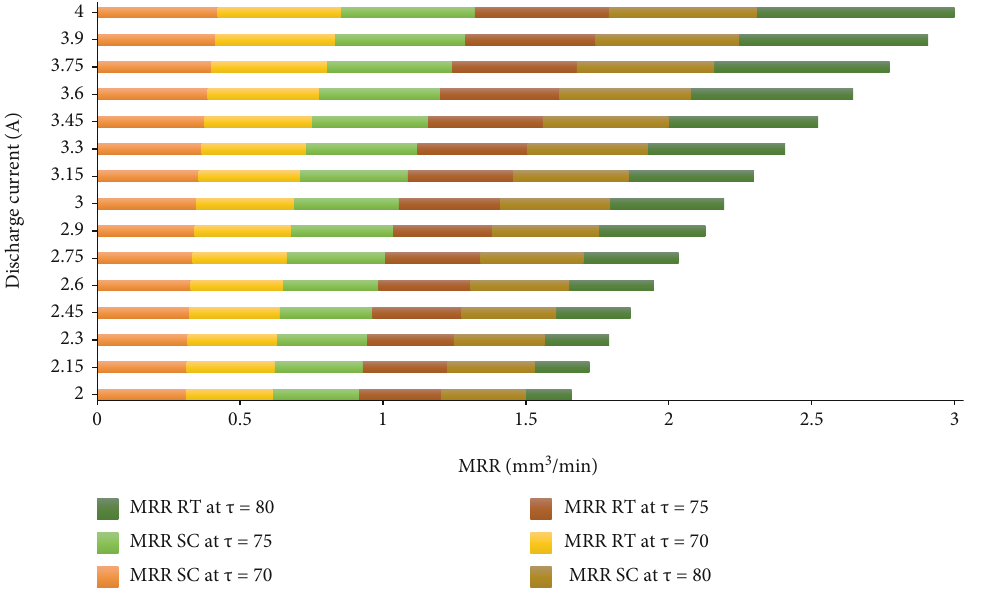
Figure 6: MRR vs. discharge current for two types of electrodes at T